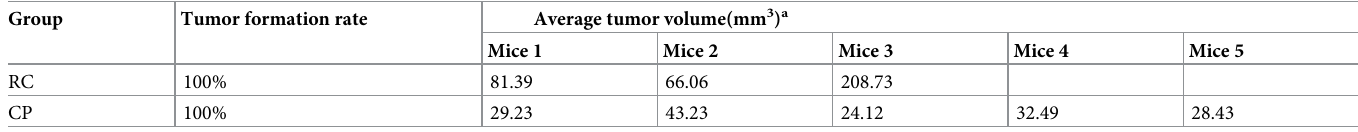
Table 2. The occurrence of tumors in